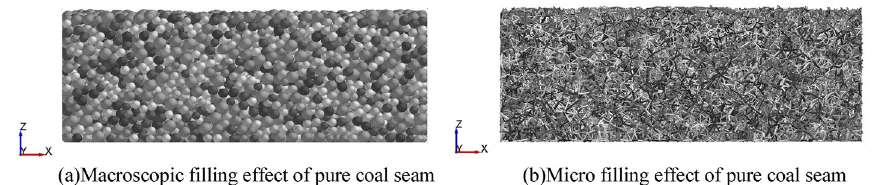
Figure 4. Space filling diagram of pure coal seam.